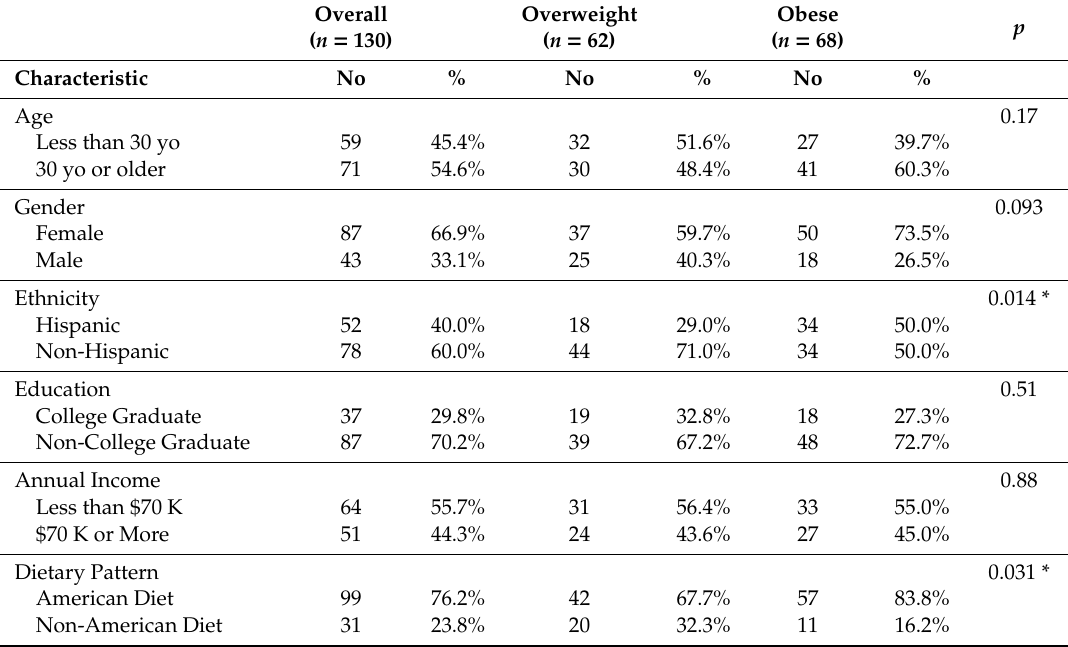
Table 1. Baseline participant